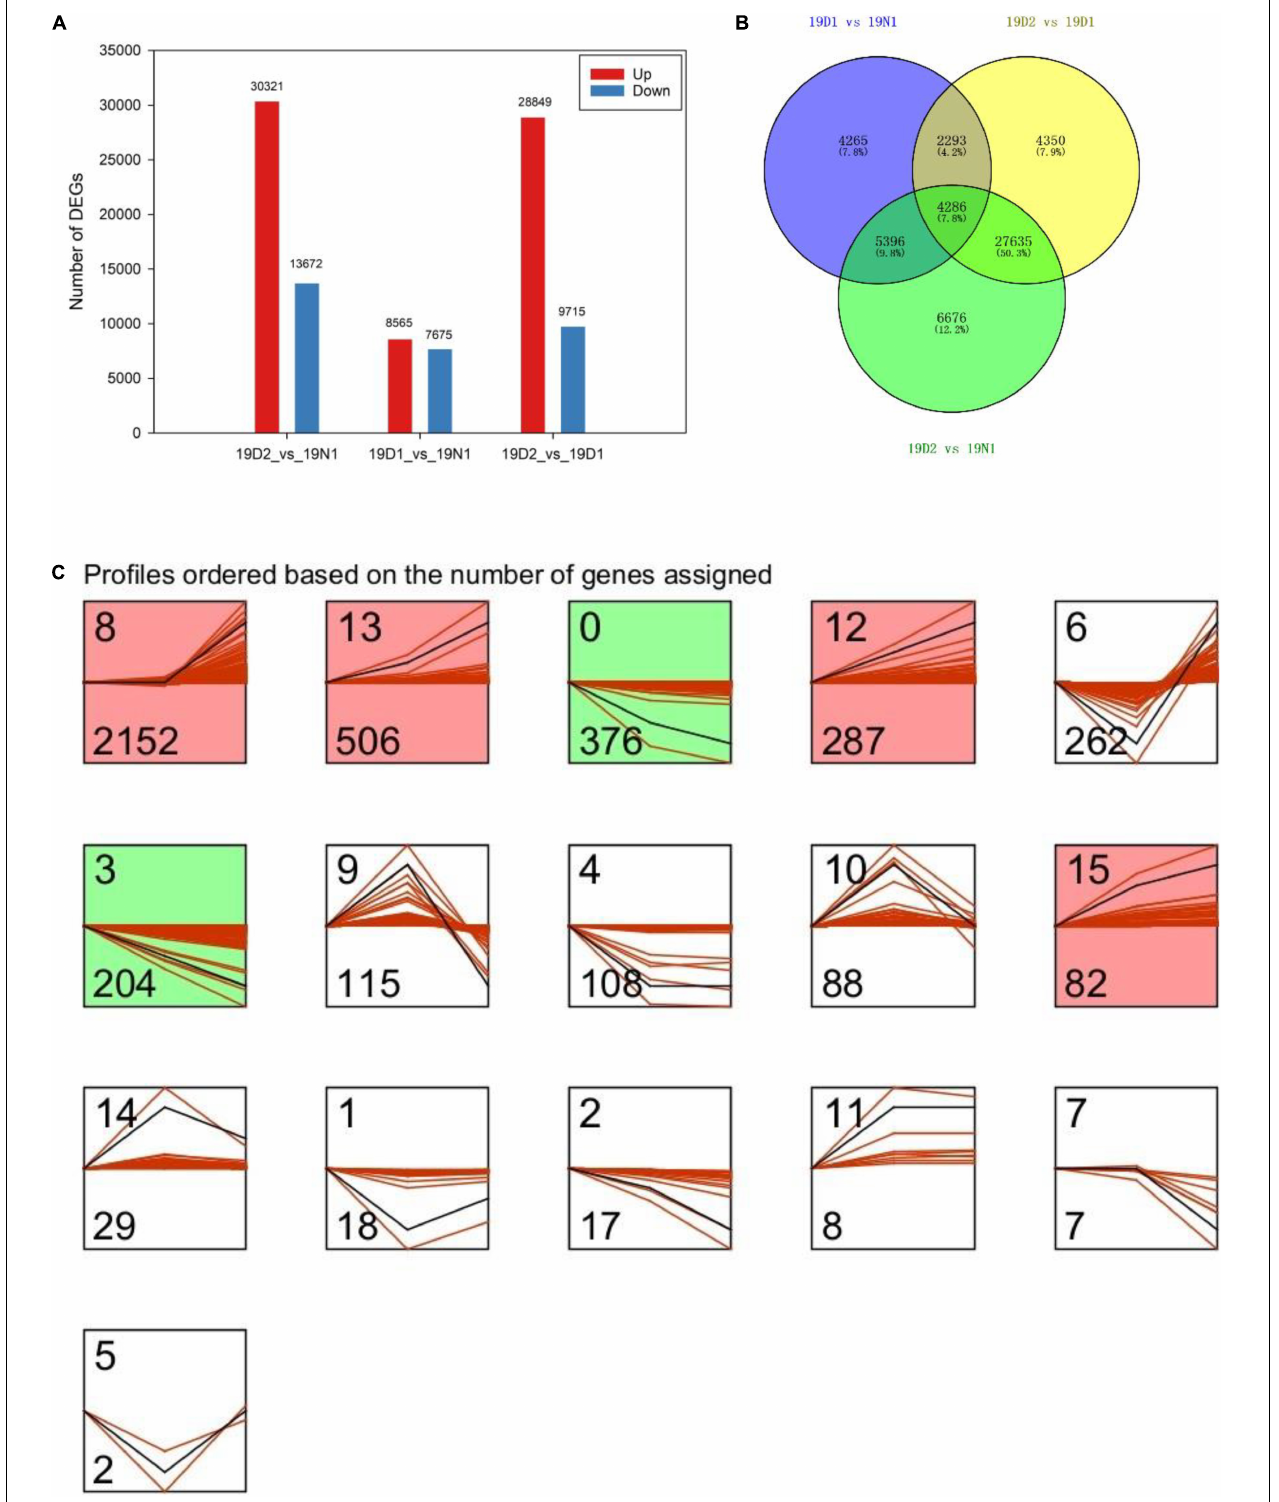
FIGURE 3 | Expression patterns of differentially expressed genes (DEGs) during different dormancy phases in Magnolia wufengensis . (A) Changes in gene expression profile during different dormancy phases. (B) Venn diagram of DEGs between 19D1 versus 19N1, 19D2 versus 19N1, and 19D2 versus 19D1. (C) Trend analysis of 4,286 intersecting DEGs in panel (B)